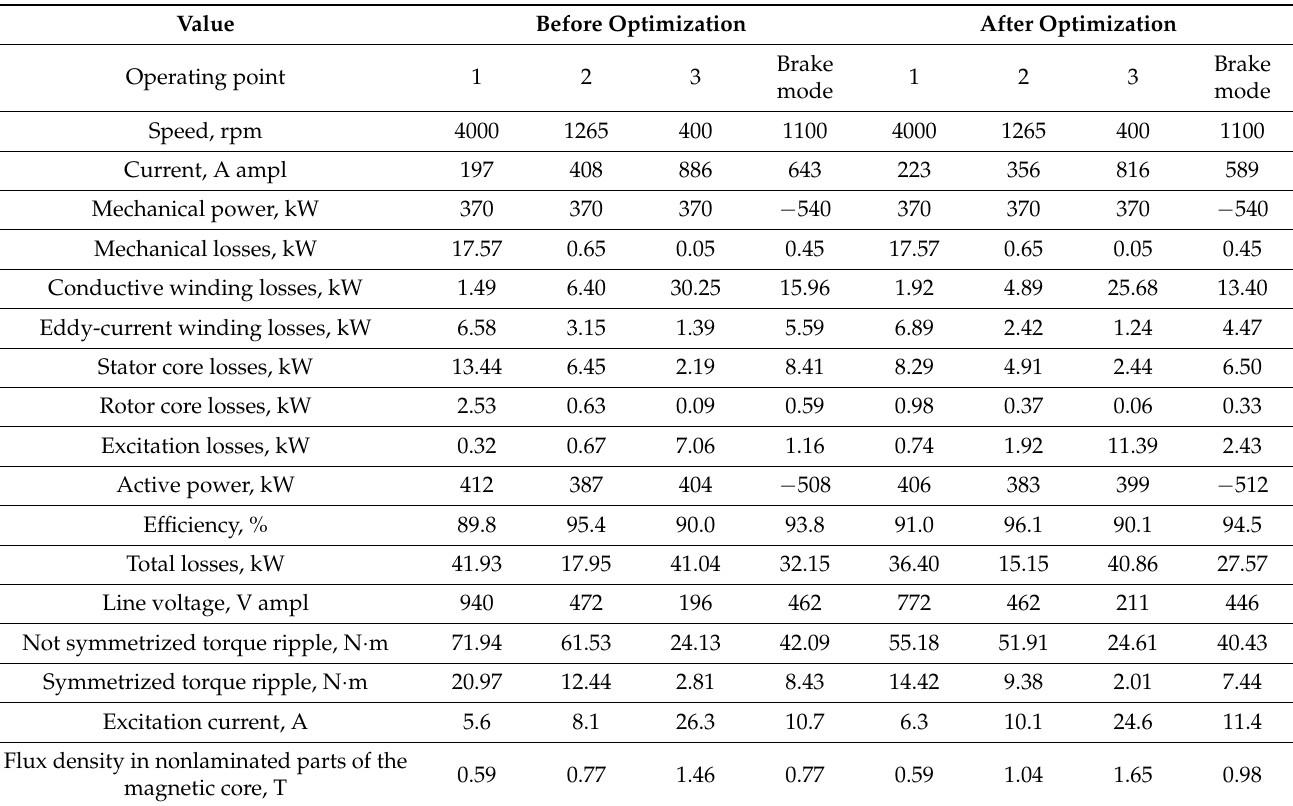
Table 4. Optimization